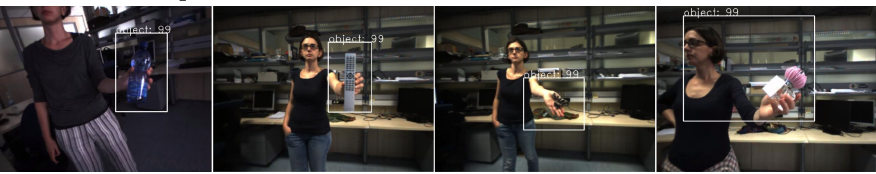
Figure 6. Results on the fruits dataset and the iCubWorld dataset using Faster R-CNN. For both, the corresponding models F and I has been trained for 200 epochs. Panel ( a ): The metrics (mAP@0.5, recall and precision) on the validation datasets are calculated after each 10th epoch (orange line: fruits, blue line: iCubWorld). For both models F and I , the metrics reach high values after only a few epochs. Panel ( b ): Inference examples of F and F + on the fruits test dataset. For each object, the results of F and F + are shown on the left and right, respectively. The potato is well annotated by both models, while the carrot benefits from the additional slack in F + . For the pliers and the tape, F detects multiple bounding boxes resulting in a very good annotation of F + . Figure reused from our recent work [8]. Panel ( c ): Inference examples of I + on the iCubWorld test dataset. The first two examples are well annotated, while the inferred bounding boxes in the remaining examples are too large due to inclusion of the human hand (hair clip) and incorrectly detected boxes merged with correct boxes (perfume). More detailed results on the absolute numbers of correct and incorrect annotations can be found in Figure